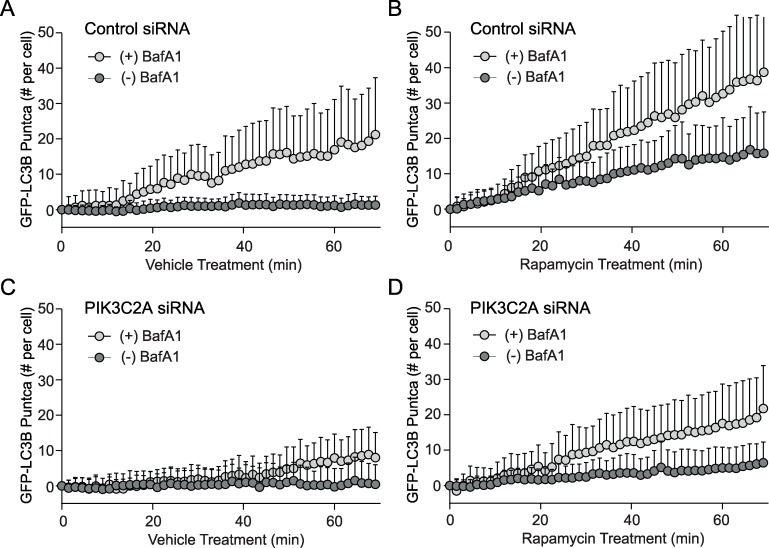
PI3K-C2α is a positive regulator of autophagy.(A-D) The number of GFP-LC3-II puncta that accumulated in the presence (light gray circles) or absence (dark gray circles) of BafA1 was plotted (t = 0 through t = 70 min). Values on the vertical axis represent mean numbers of puncta with adjustment such that the value at t = 0 is 0. Means were adjusted by subtracting the mean number of vesicles at t = 0. (A) Vehicle treated control siRNA cells, and (B) rapamycin induced autophagy in control siRNA conditions after rapamycin addition at time t = 0. (C, D) PIK3C2A siRNA knockdown (48 hours) and cells treated with vehicle control (C) or rapamycin (D). Bars represent standard deviations.